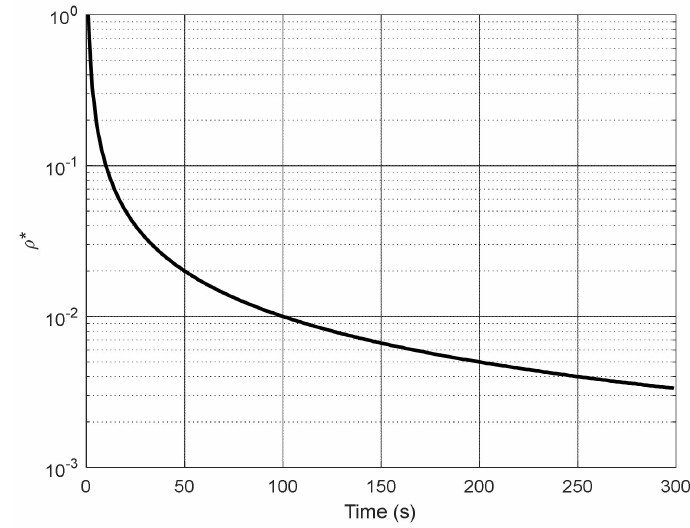
Figure 7. The curve of optimal ρ ∗